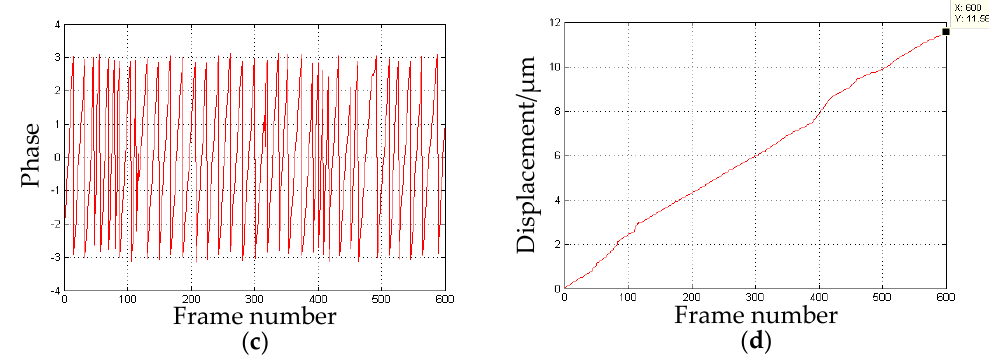
Figure 13. The z -direction displacement: ( a ) the intensity distribution over time; ( b ) the intensity after amplification and smoothing processing; ( c ) the discontinuous phase map obtained by CWT; and ( d ) the measured displacement over time.